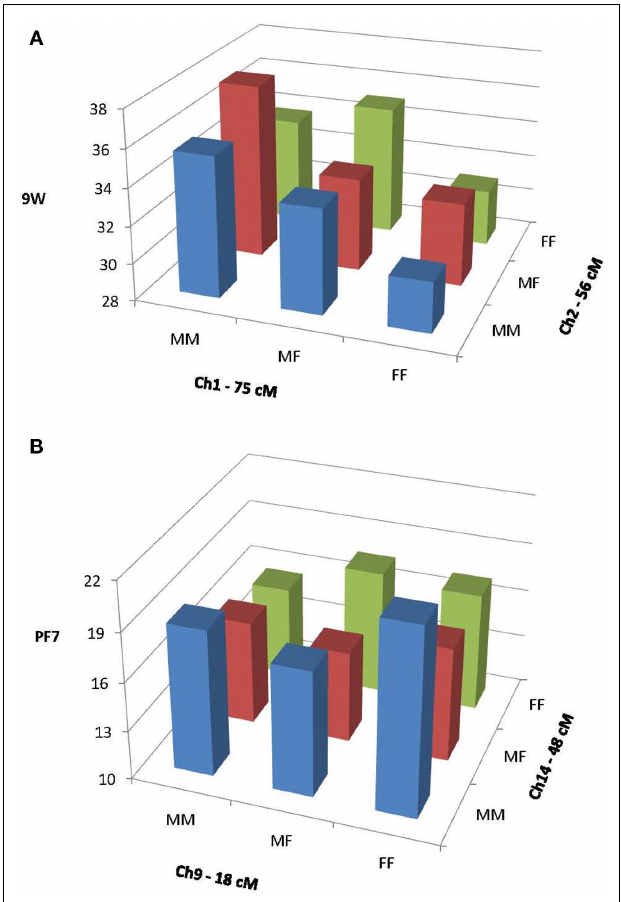
FIGURE 1 | Epistatic interactions between QTLs on chromosomes 1 and 2 affecting 9W (A) and between QTLs on chromosomes 9 and 14 affecting PF7 (B). MM, M16i/M16i homozygotes; MF, M16i/FVB heterozygotes; and FF, FVB/FBV